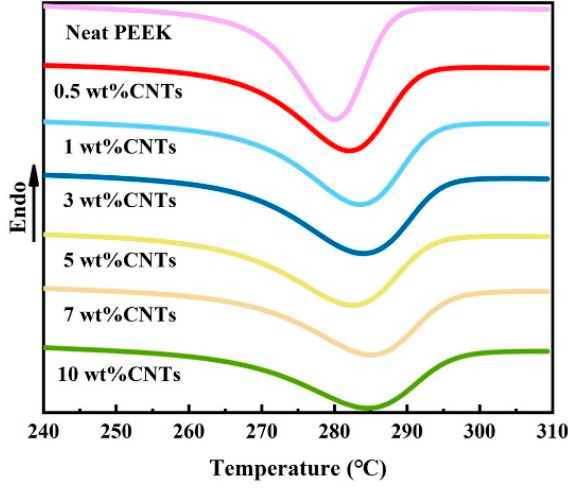
Figure 4. DSC cooling curves at various CNTs content for PEEK/CNTs composites. Table 2. Non ‐ isothermal crystallization parameter of the PEEK/CNTs composites.